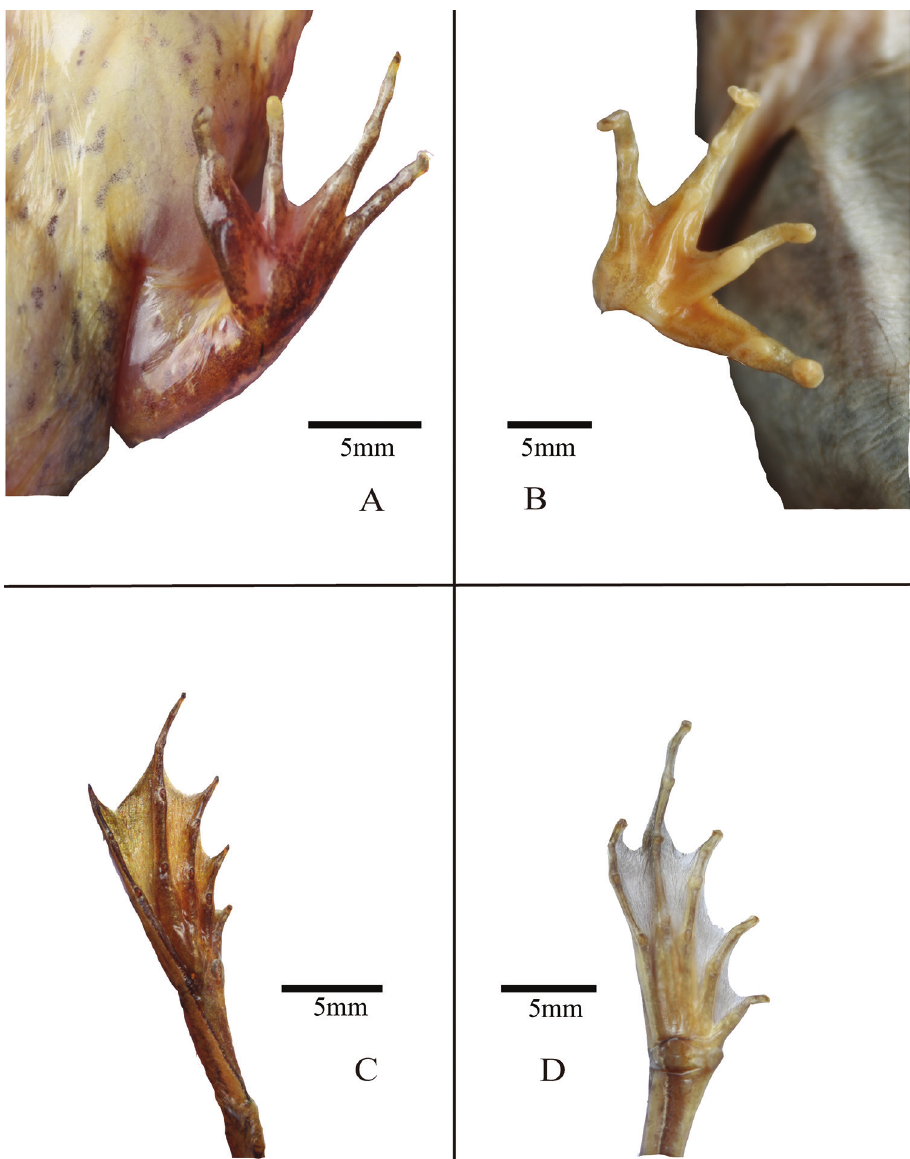
Figure 4. A volar view of the left hand of the holotype in life (AHU2016R001, male) B volar view of the right hand of female paratype in preservative (AHU2016R010, famle) C thenar view of the right foot of the holotype in life (AHU2016R001, male) D thenar view of the right foot of the female paratype in preservative (AHU2016R010, famle). with irregular black spots; nuptial pad grayish brown. In preservative, dorsal surface gray-brown; all ash black fade to black; throat, chest, and abdomens fade to creamy white, with gray